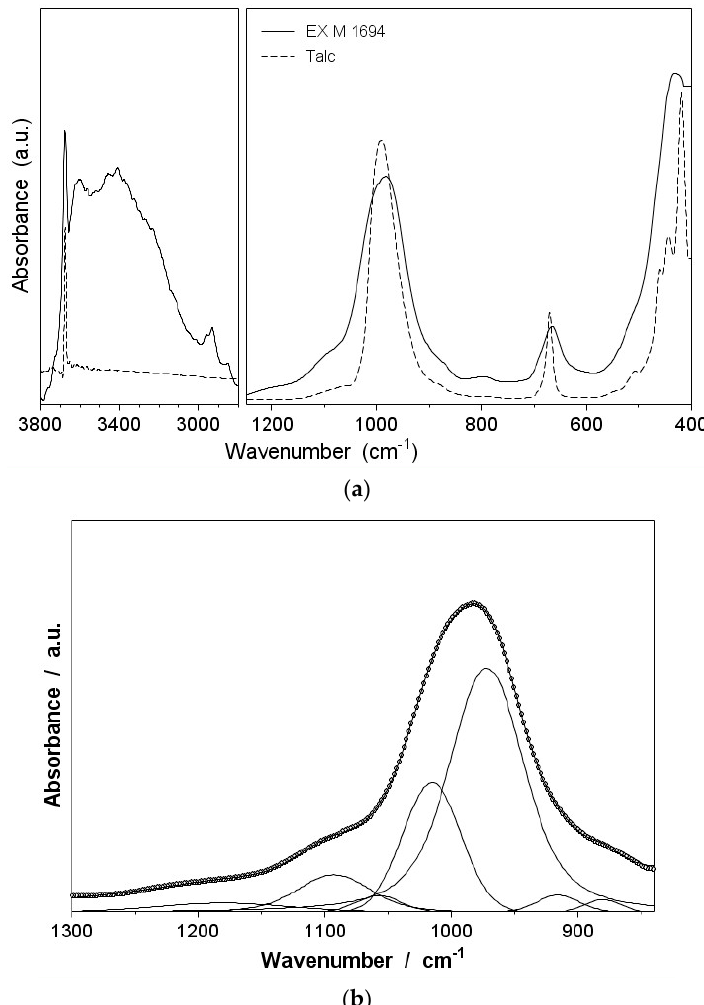
Figure 3. ( a ) Comparison of FTIR-ATR spectra of sample EX M 1694 and of talc; ( b ) Results of the spectrum deconvolution in the region between 830 and 1300 cm − 1 . The band positions are at 880, 916, 973, 1015, 1057, 1092 cm − 1 .